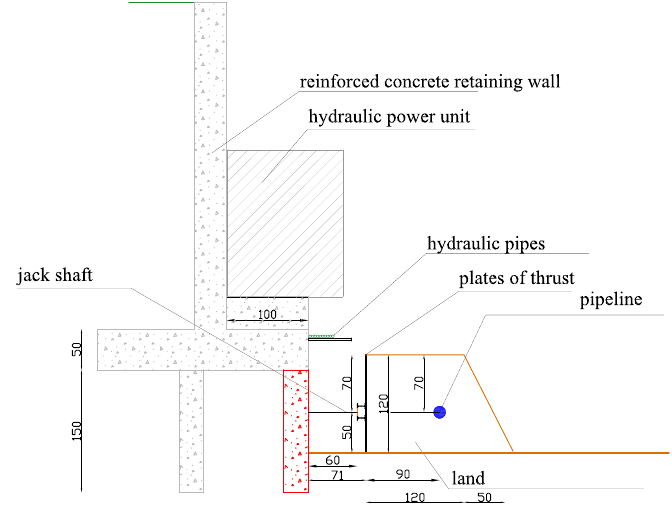
Figure 7. Transversal section of the test bench (lengths in cm).